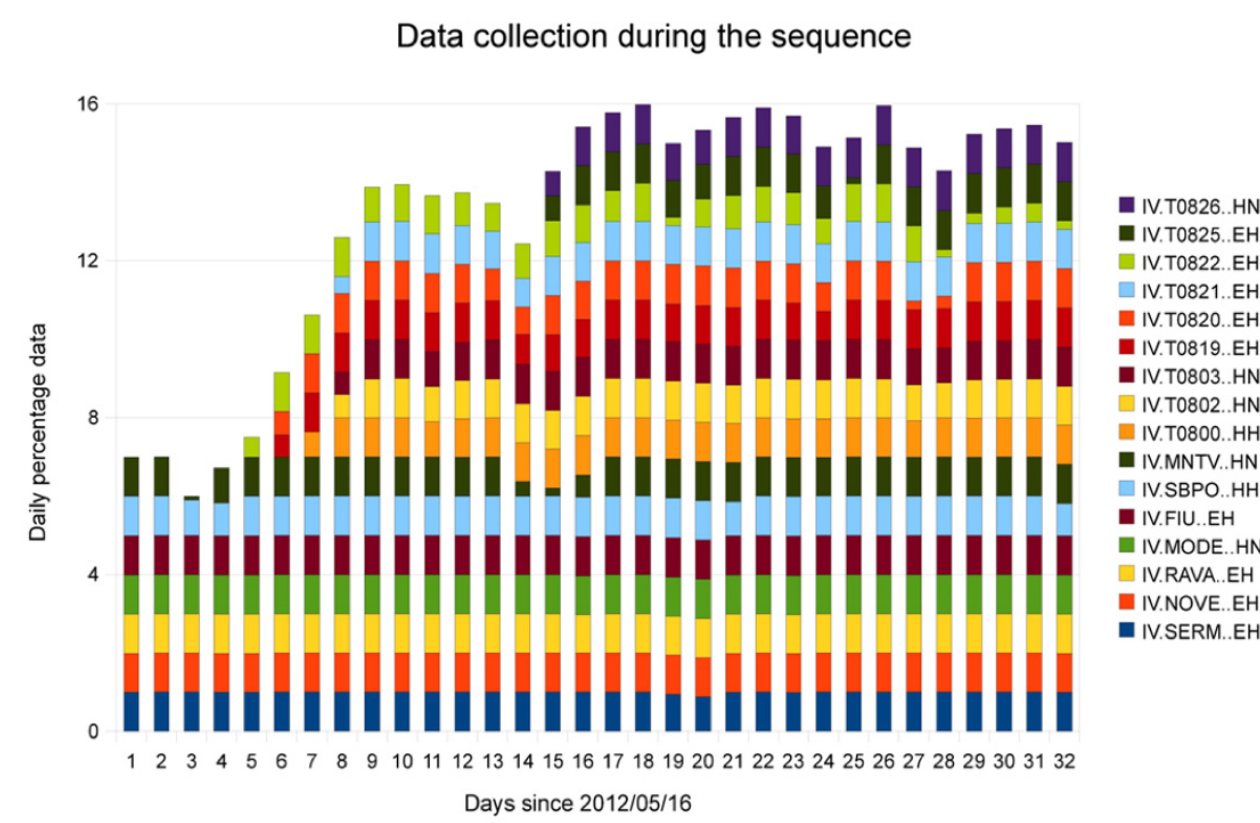
Figure B2. Up-time diagram of the stations in the epicentral